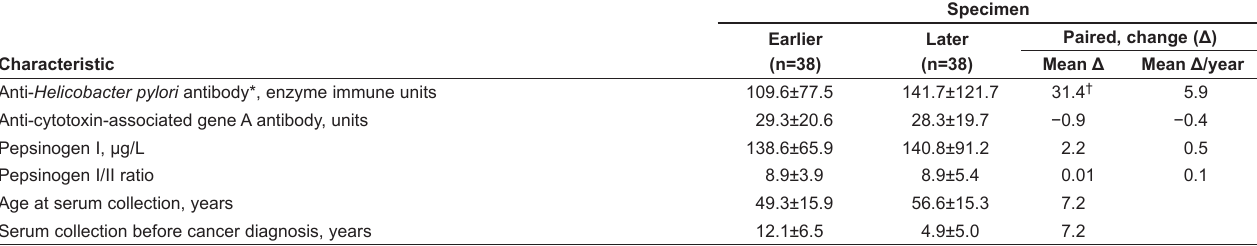
TAble 3 Characteristics of paired sera taken before gastric cancer diagnosis